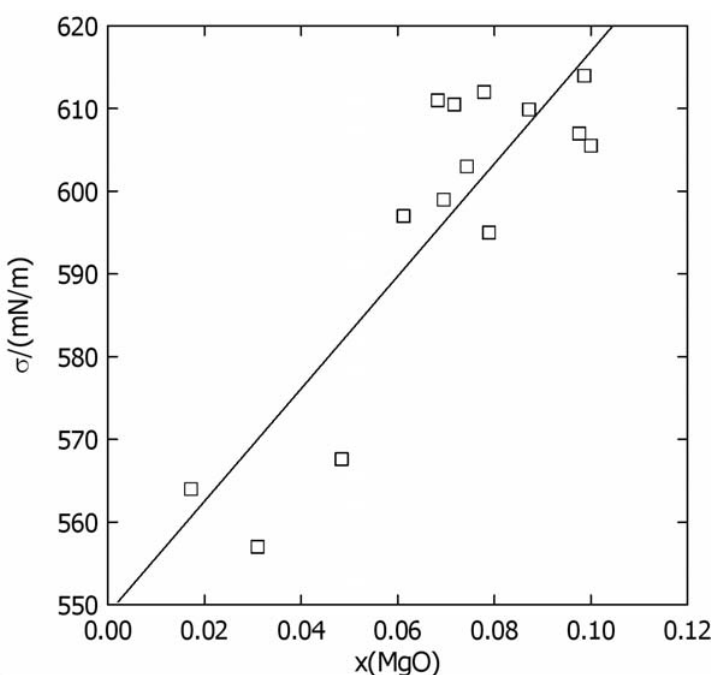
Fig. 2 Dependence of the surface tension of melts of the system CaO − FeO-Fe 2 O 3 − MgO on the content of MgO at the temperature of 1623